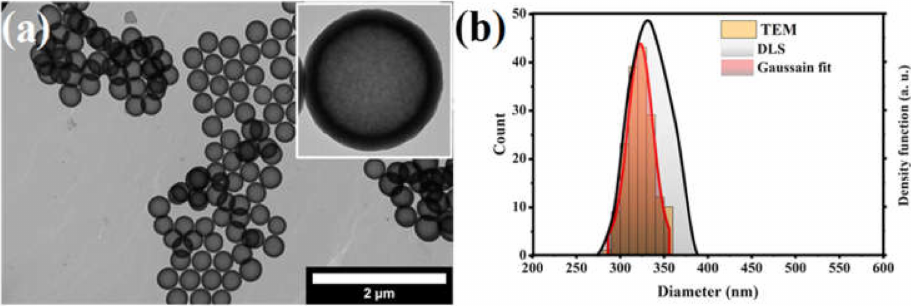
Figure 2. TEM image of the unmodified pHOP sample ( a ), and the particle size distributions of pHOPs based on TEM and DLS ( b